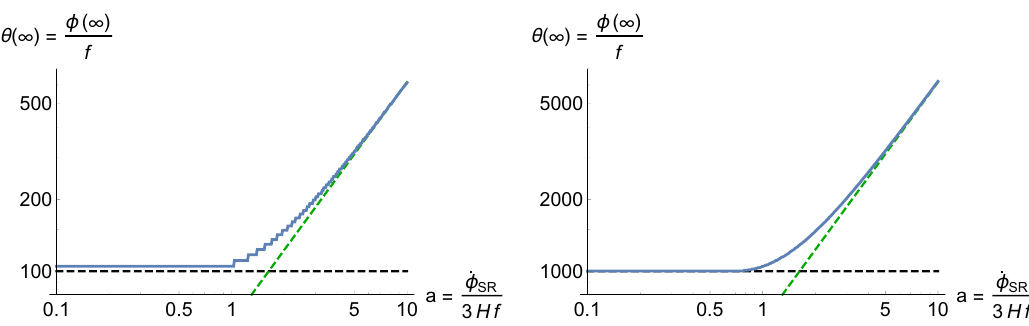
Figure 10 . lim (cid:28) !1 (cid:18) ( (cid:28) ) of the solution of eq. (B.4). We take b = 100 in the left panel, and 1000 in the right panel. The black dashed line shows (cid:18) ( (cid:28) ) = b , and the green dashed line shows (cid:18) ( (cid:28) ) = ( (cid:25) 2 = 16) ab